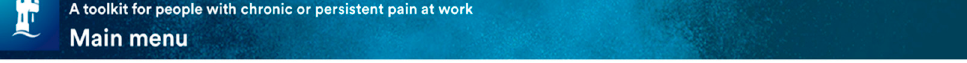
Figure 3. PAW Toolkit sections and content.